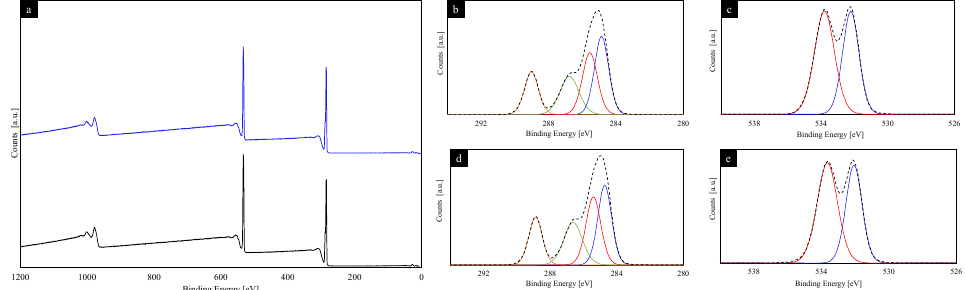
Figure 2. XPS spectral comparison for ( a ) wide energy survey scans of 25PS75PMMA (black) and 25PS75PMMA_750 (blue) substrates with related deconvoluted high energy plots for C 1s of ( b , d ) showing blue, red, green, orange and dotted lines relating to C-H hydrocarbon, C-C-O beta-shifted carbon, C-O methoxy group and O-C=O carbonyl bond and spectral envelope, respectively and O 1s ( c , e ) showing blue, red and dotted lines corresponding to O=C carbonyl, O-C methoxy group oxygens and the oxygen spectral envelope, for 25PS75PMMA and 25PS75PMMA_750 substrates, respectively.